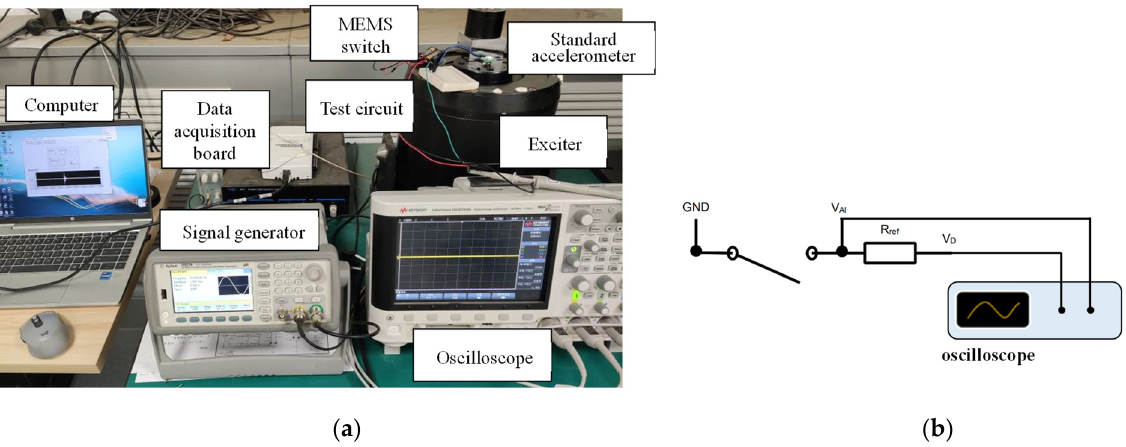
Figure 13. ( a ) The experimental setup of the shaker system; ( b ) test circuit of the electrical performance.